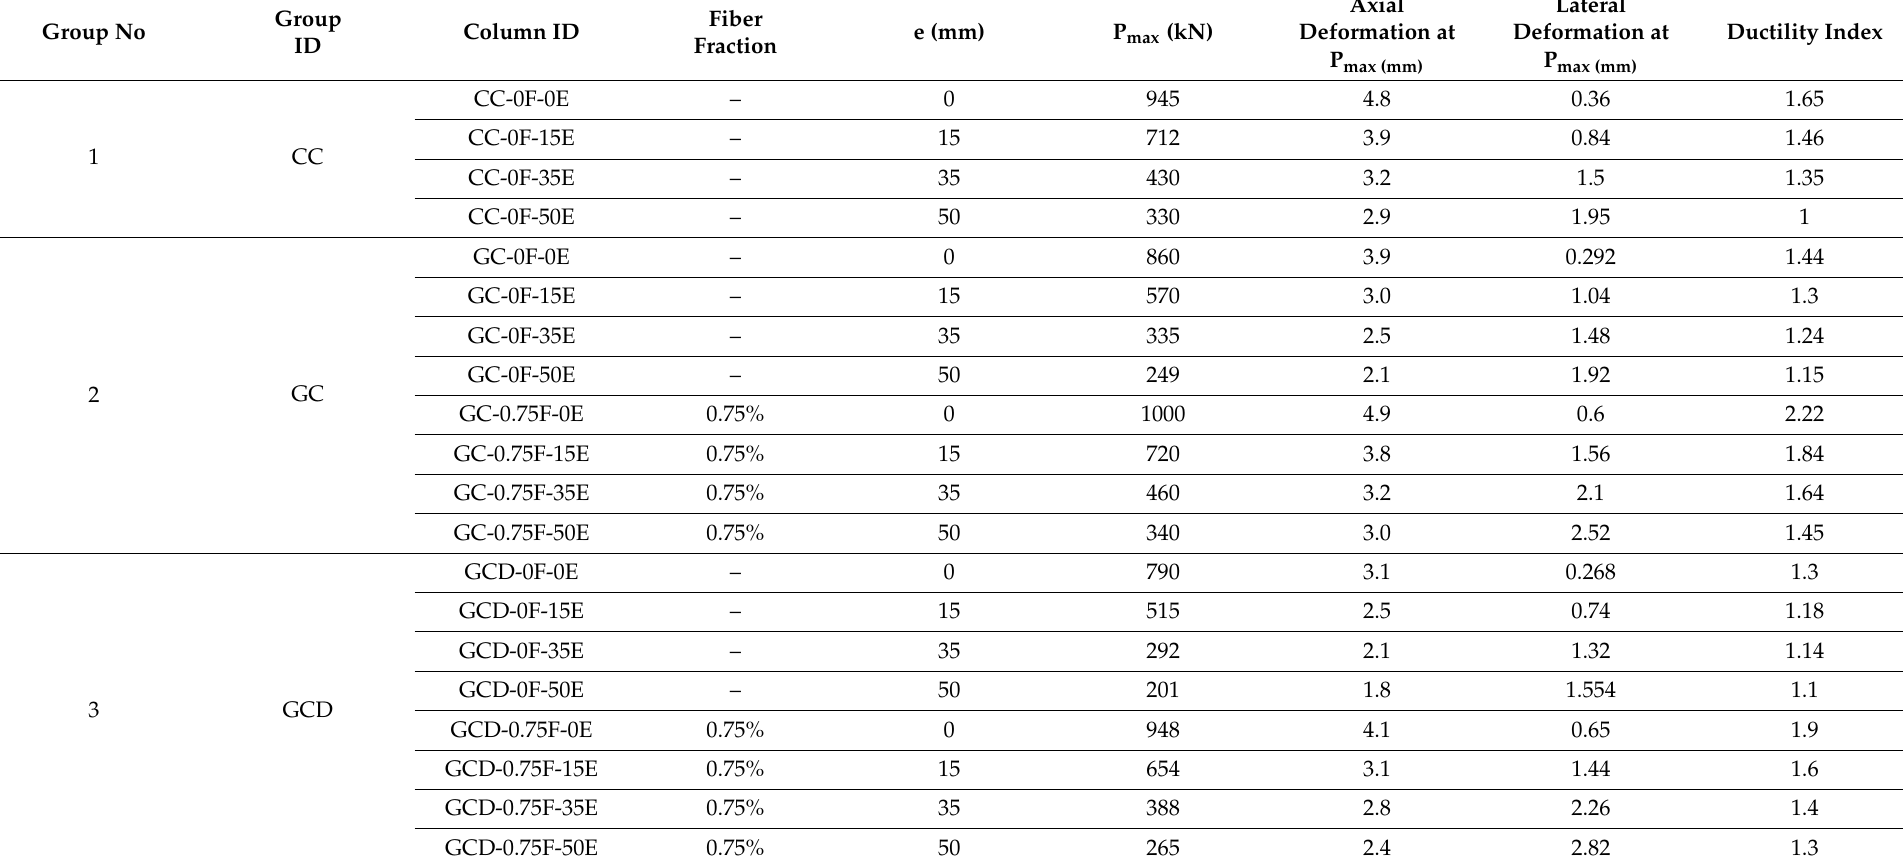
Table 6. The test results of column specimens, including ductility